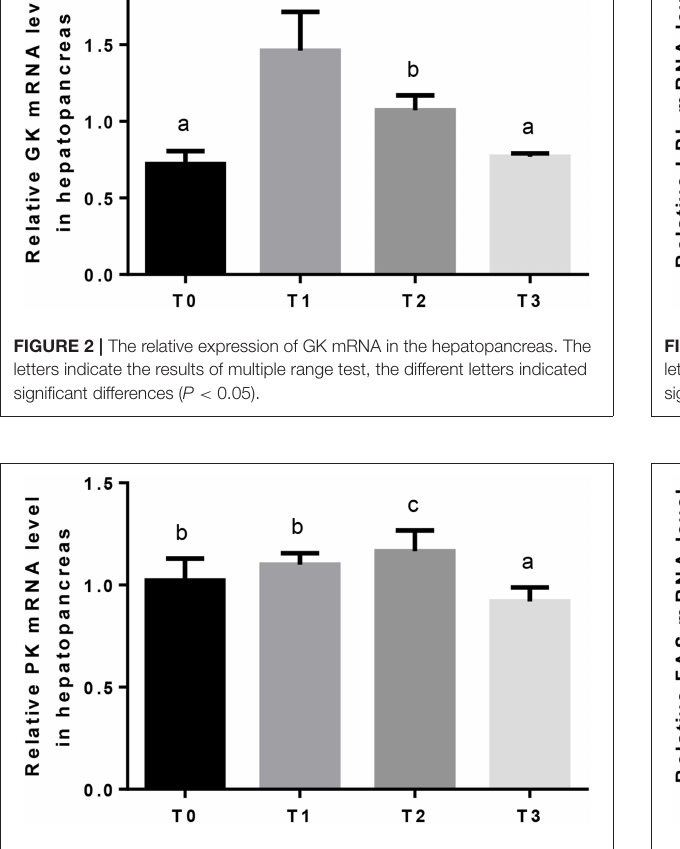
FIGURE 3 | The relative expression of PK mRNA in the hepatopancreas. The letters indicate the results of multiple range test, the different letters indicated significant differences ( P < 0.05).